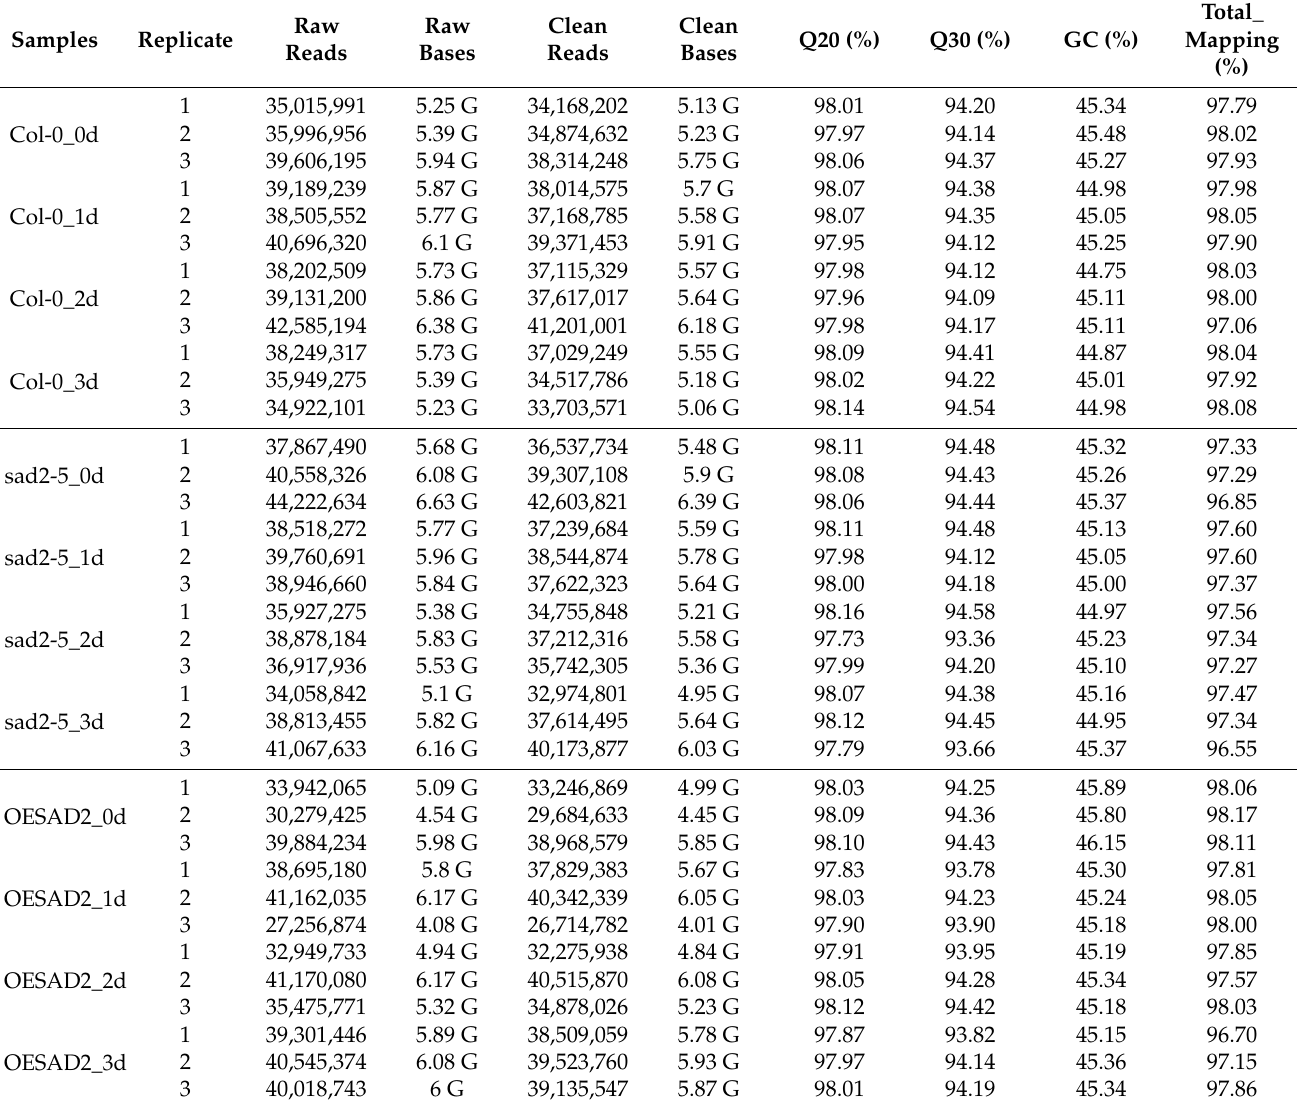
Table 1. Summary of sequencing